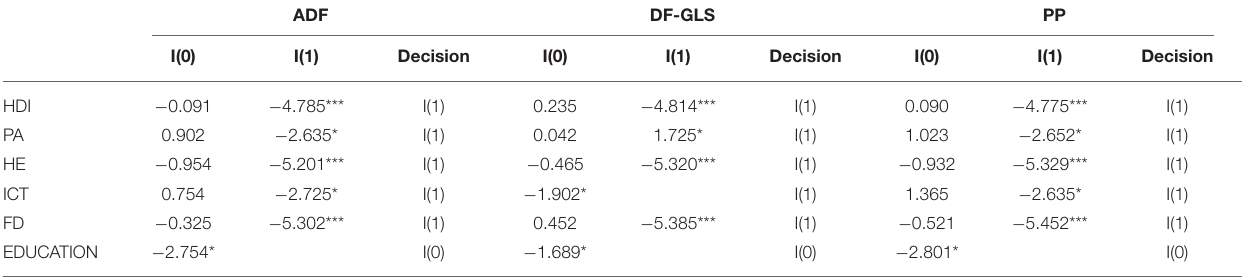
TABLE 2 | Unit root